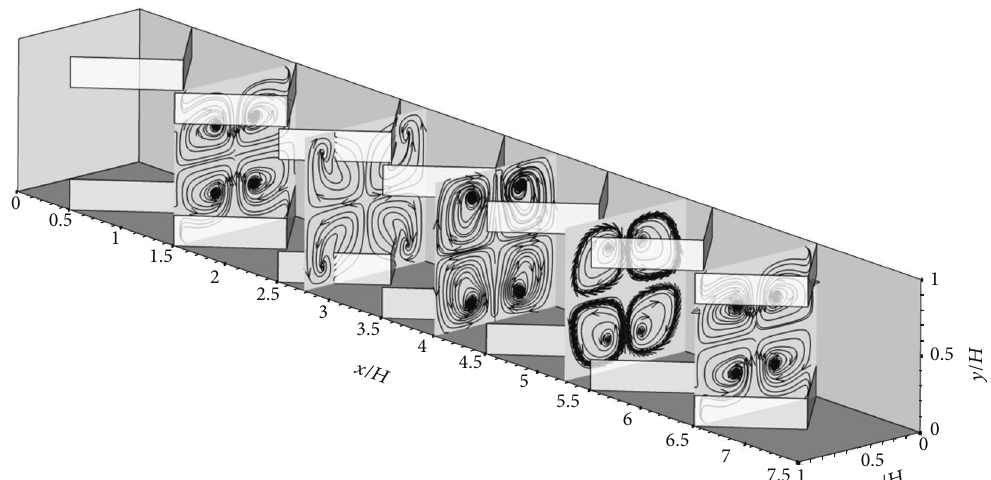
Figure 4: Streamlines in transverse planes for 𝛼 = 45 ∘ of V-Downstream rib at Re = 800 , BR = 0.20 , and PR = 1 .